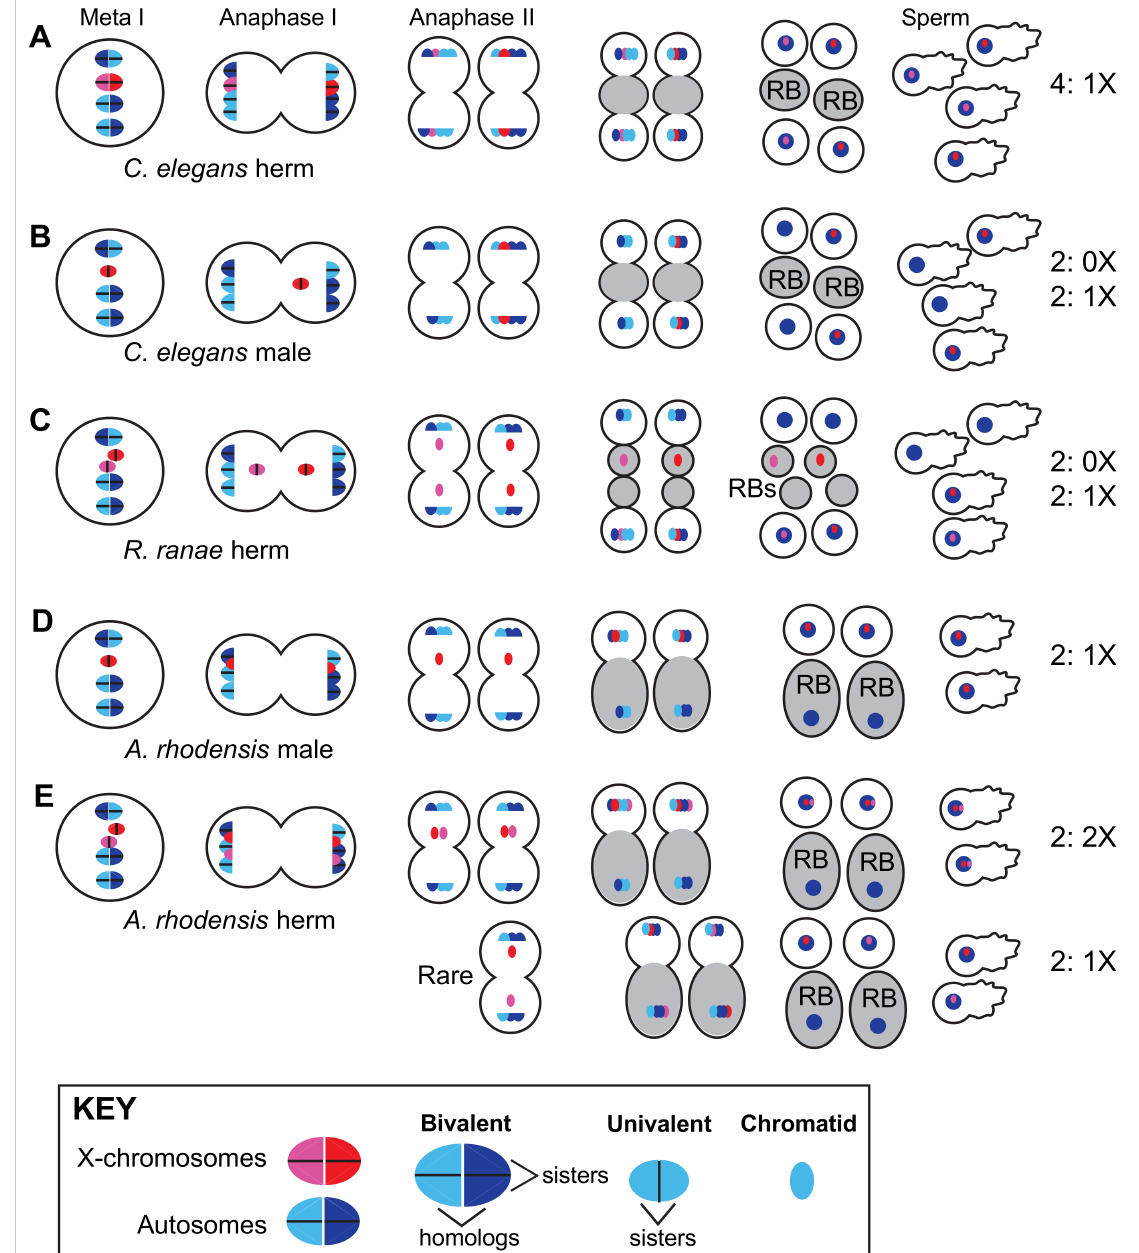
Figure 2. Mendelian and non-Mendelian patterns of X-chromosome segregation during nematode spermatogenesis. ( A ) In the meiotically dividing spermatocytes of XX C. elegans hermaphrodites, the homologous X chromosomes (red/pink) pair, recombine, and segregate in a manner indistinguishable from the autosomes (blue). The products of spermatogenesis are four 1X sperm. An important but unusual feature of nematode spermatogenesis is that a residual body (gray) forms between the haploid sperm immediately following anaphase II, rather than after an extended, post-meiotic process of sperm differentiation. In addition, the sperm locomote using a pseudopod rather than a flagellum. ( B ) Meiotically dividing spermatocytes of C. elegans males have a single X chromosome (an unpaired univalent) which lags during anaphase I and ultimately segregates to one of the two secondary spermatocytes. Spermatogenesis ultimately yields two 1X and two 0X sperm. ( C ) In one variation, self-fertilizing XX Rhabdias ranae hermaphrodites can produce a limited number of 0X sperm and thus male progeny because unpaired X chromosomes lag during both meiotic divisions and lagging X chromatids can be left behind in the residual body following anaphase II. ( D ) In spermatocytes of Auanema rhodensis males, the single X chromosome splits into sister chromatids during meiosis I. During meiosis II, the X-bearing chromosome complement segregates with the functional sperm components, whereas the non-X bearing chromosome complement segregates to